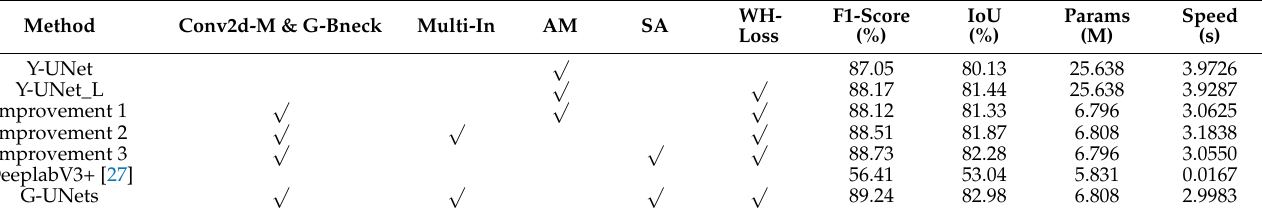
Table 2. Network model performance and parameter